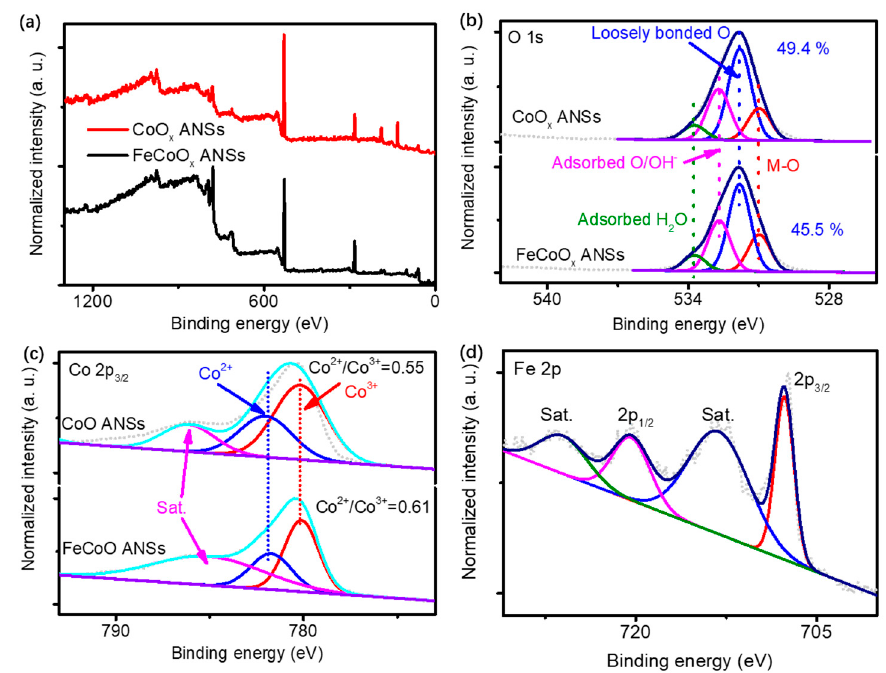
Figure 3. XPS spectrum of CoO x ANSs and Fe 1 Co 1 O x ANSs. Survey spectrum ( a ), O 1s spectrum ( b ), Co 2p spectrum of CoO x ANSs and FeCoO x ANSs ( c ), and Fe 2p spectrum of FeCoO x ANSs ( d ). The Fe loading on CoO x ANSs makes the change of Co 2p peaks, verifying the strong synergistic effect between Fe and Co oxides in 2D structures.